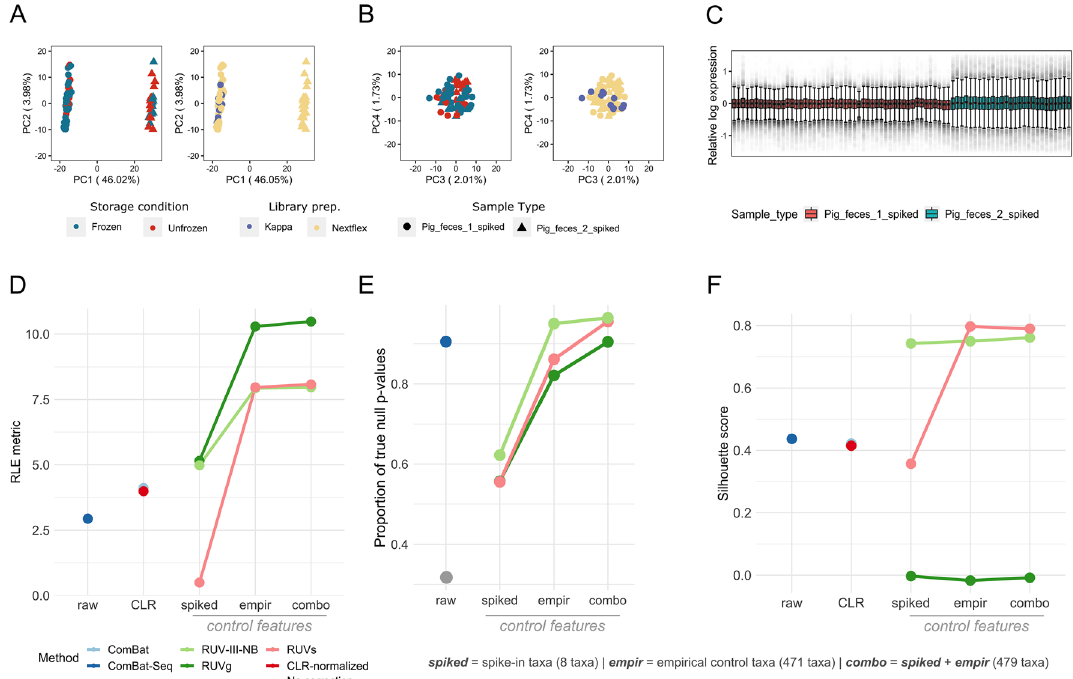
Figure 3. (A) PC1 and PC2 of all spiked samples after RUV-III-NB correction showing retained separation based on sample origin, yet (B) clustering based on storage conditions and library preparation kits used is no longer present in PC3 and PC4, suggesting successful removal of unwanted variations. (C) RLE plot of all spiked samples after RUV-III-NB correction, showing successful removal of unwanted variations represented by the medians of sample from the same individual being as close to zero as possible and as linear to each other as possible, as well as similar interquartile ranges (IQR) between the samples visualized by the size of the boxplot. (D) Comparison of correction method performances between mere CLR-normalization, ComBat-based methods (which only processes either raw or CLR-transformed dat), and RUV-based methods (which leverages negative control features); based on relative log expression (RLE metric), where higher number indicates better removal of overall unwanted variations. With the exception of RUVs with solely spike-in taxa as control features, RUV methods in average performed better compared than ComBat-based methods. (E) Proportion of true null p-values ( π 0 ) of samples with no correction and samples corrected using different methods after differential abundance analysis. Since storage conditions were found to be the main batch variable in this dataset, comparison was done between frozen and unfrozen samples of samples from the same source (pig 1). Since edgeR requires integer counts as input, ComBat was omitted from this comparison. RUV-III-NB resulted in the highest pi0 overall when using the combination set of control taxa, and still performed better than ComBat-seq when using solely empirical taxa as control features. (F) Comparison of correction method performances in preserving individual biological information through silhouette scores, which are calculated based on the main PCs of spiked samples and explain how well samples separate between defined groups (higher = better). RUVs using solely empirical control features had the highest silhouette score in separating pig 1 and pig 2 samples, yet correction using RUV-III-NB had the highest average silhouette score overall—indicating its consistency despite the different set of control features. RUVg performed really poorly overall, with silhouette scores using all the different control features placing significantly lower than even CLR-normalized